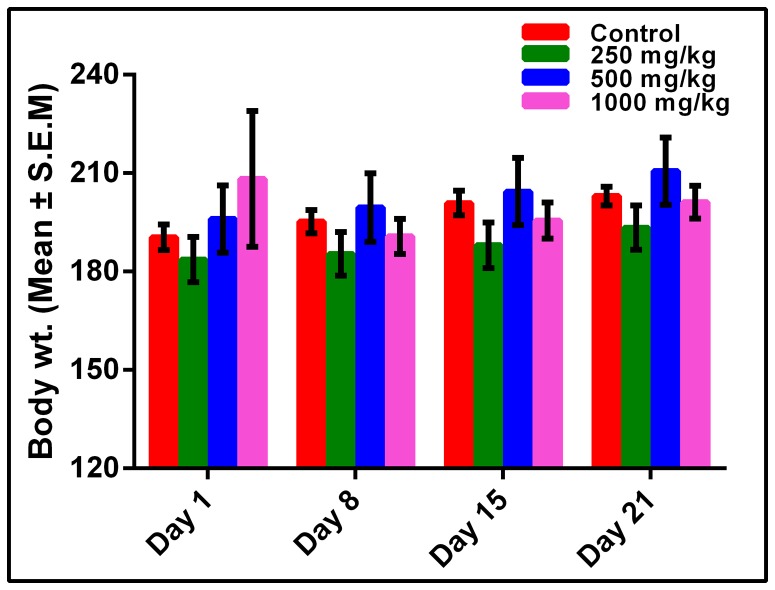
Effect of methanol extract of C. macroptera fruit on body weights (g) of Sprague-Dawley female rats in 21 days treatment period.RM ANOVA with Dunnett's multiple comparison was performed to analyze this weight variation in different days. No significant different was found when compared to control group. Time effect was found not significant (P>0.05).